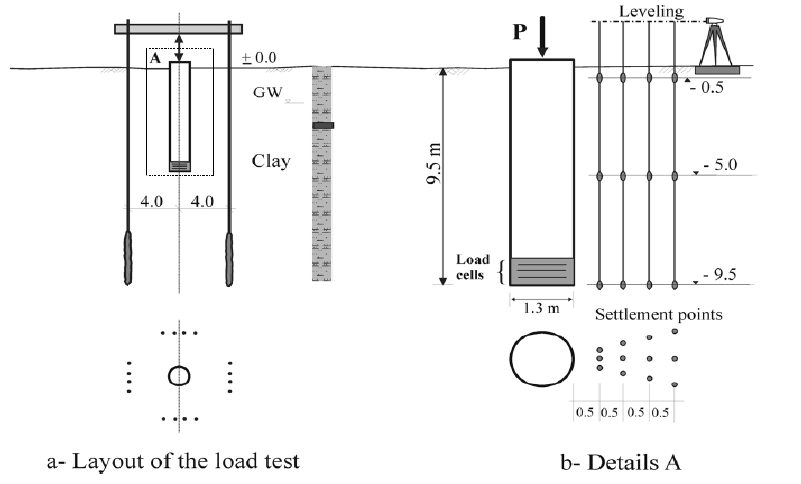
Fig. 10. Details of the pile loading test [15].